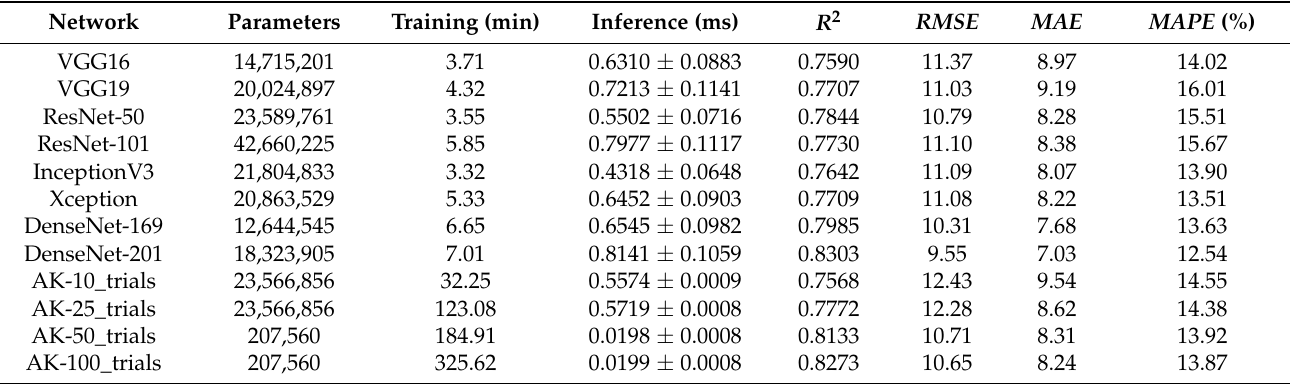
Table 4. Model performance metrics for image